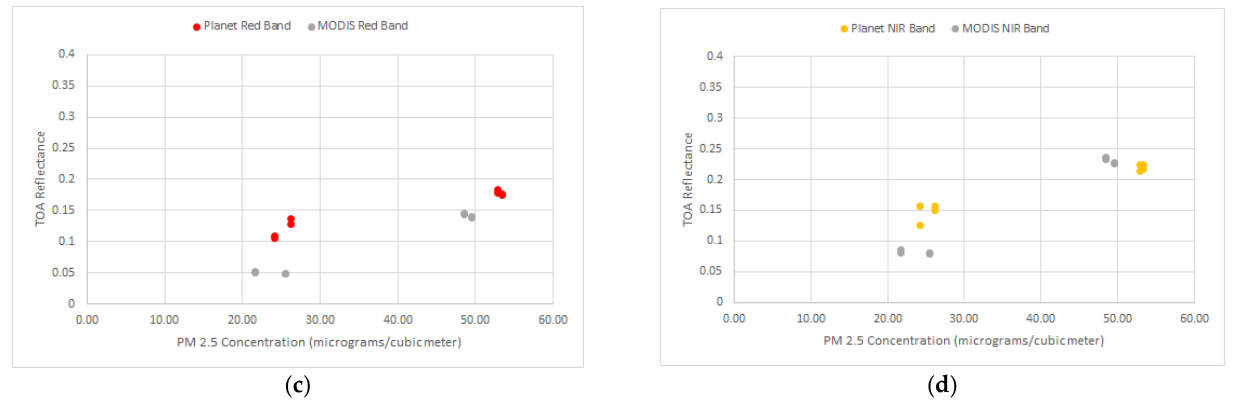
Figure 7. Data points from Figure 5 isolated for the Fresno—Garland and Clovis PM 2.5 stations for ( a ) the blue band; ( b ) green band; ( c ) red band; ( d ) and NIR band. Low PM 2.5 values are from 1/3/2019 and high PM 2.5 values are from 8/7/2018.